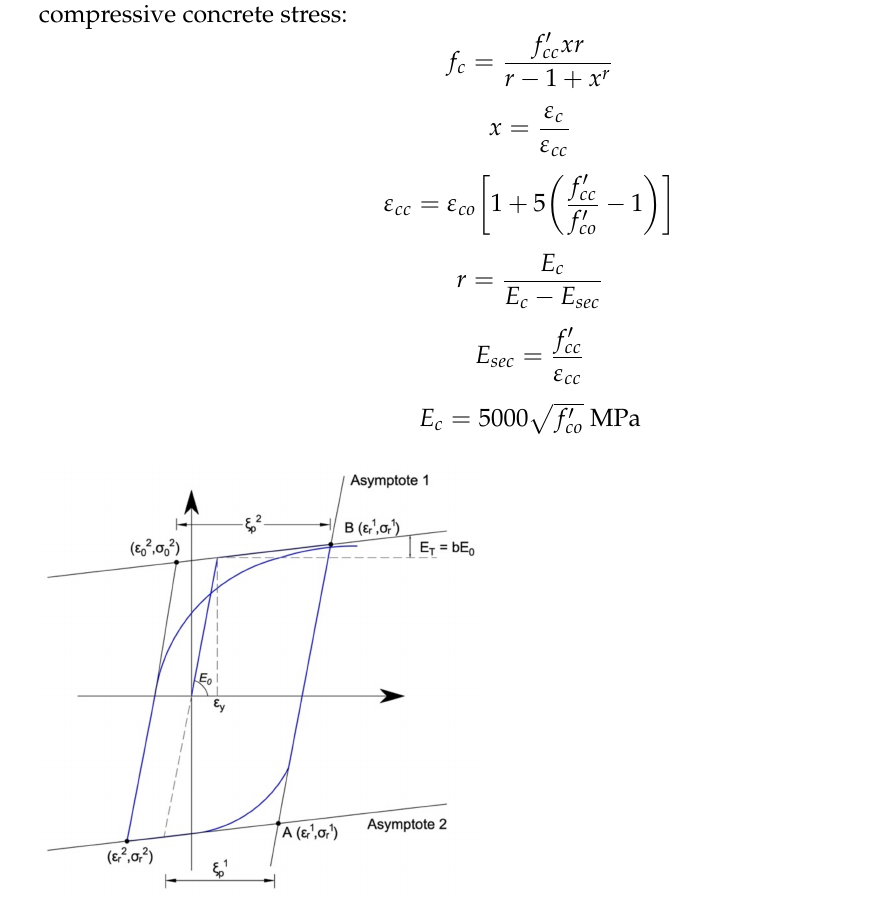
Figure 9. Stress–strain relationship of the reinforcing steel material models used in inelastic beam– column members.